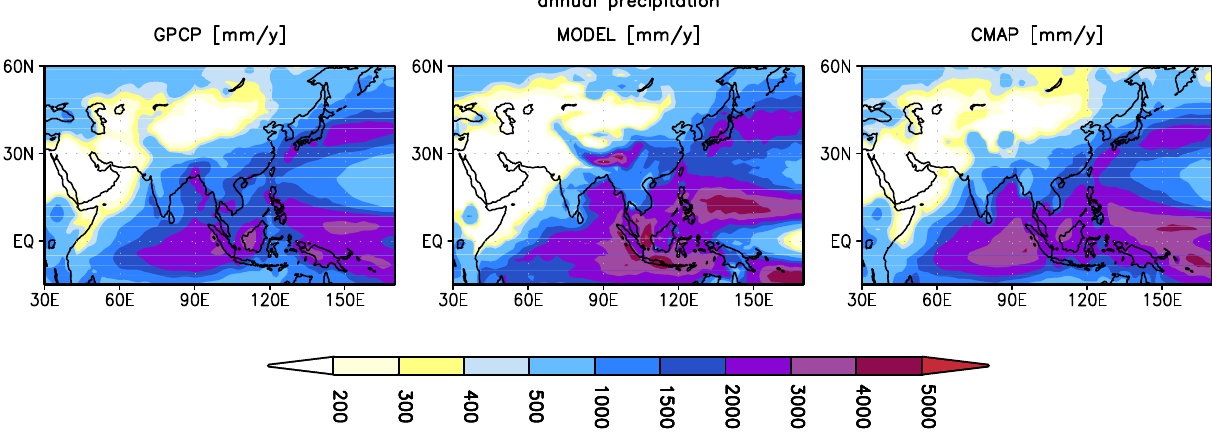
Fig. A2. Simulated annual precipitation [mmyr − 1 ] compared to the observational datasets of GPCP (Adler et al., 2003) and CMAP (Xie and Arkin, 1997). Values are taken from the CTRL simulation.